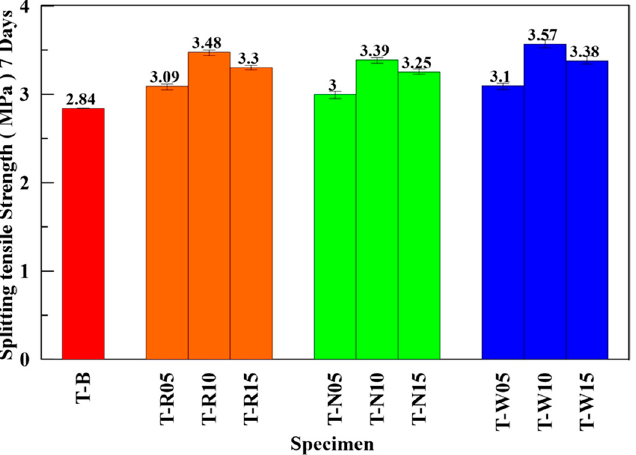
Figure 13. Average splitting tensile strength of ECFRC and benchmark specimens.